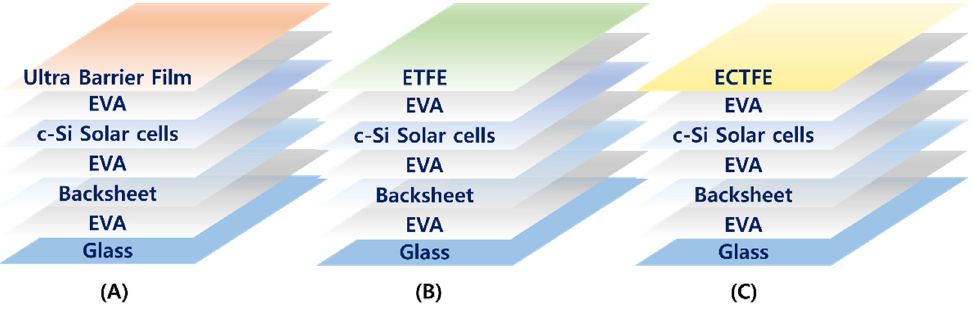
Figure 3. Structure of PV module according to front materials ( A ) UBF PV module; ( B ) ETFE PV module; ( C ) ECTFE PV module.